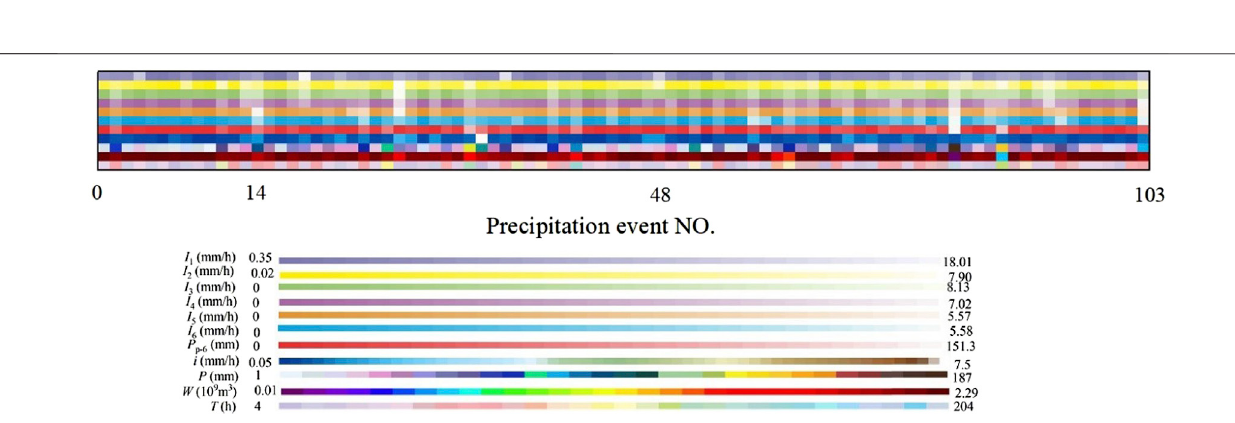
Frontiers in Environmental Science |